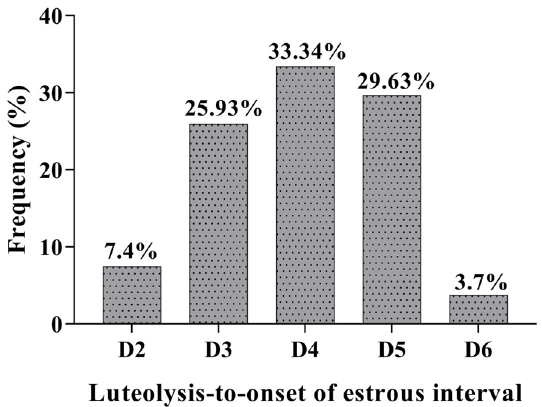
Figure 3. Intervals from sodium cloprostenol treatment to onset of estrus in gilts with prolonged luteal function (CYP gilts). The data are presented as frequency per total number of gilts.